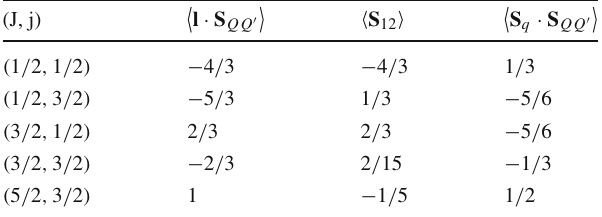
Table 4 The matrix elements of the mass splitting operators in the p-wave doubly heavy baryons states in the jj